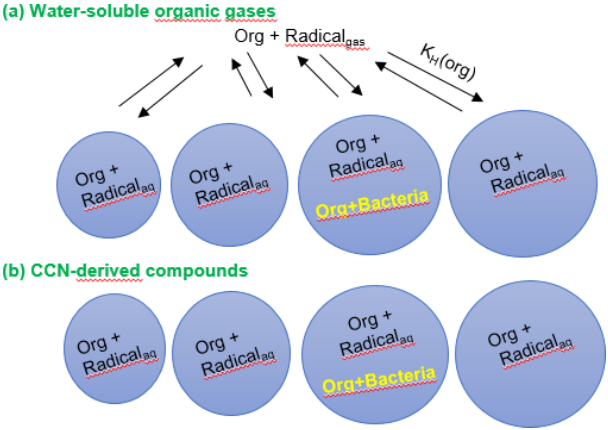
Figure 1. Schematic of the multiphase box model including chemi- cal radical reactions in the gas and aqueous phases. Chemical reac- tions occur in both phases and in all droplets, whereas biodegrada- tion processes only occur in the aqueous phase in a small fraction of droplets, depending on the assumed bacterial cell concentration in clouds. (a) Water-soluble organic gases that partition between the two phases; (b) CCN-derived compounds that only get processed in the aqueous